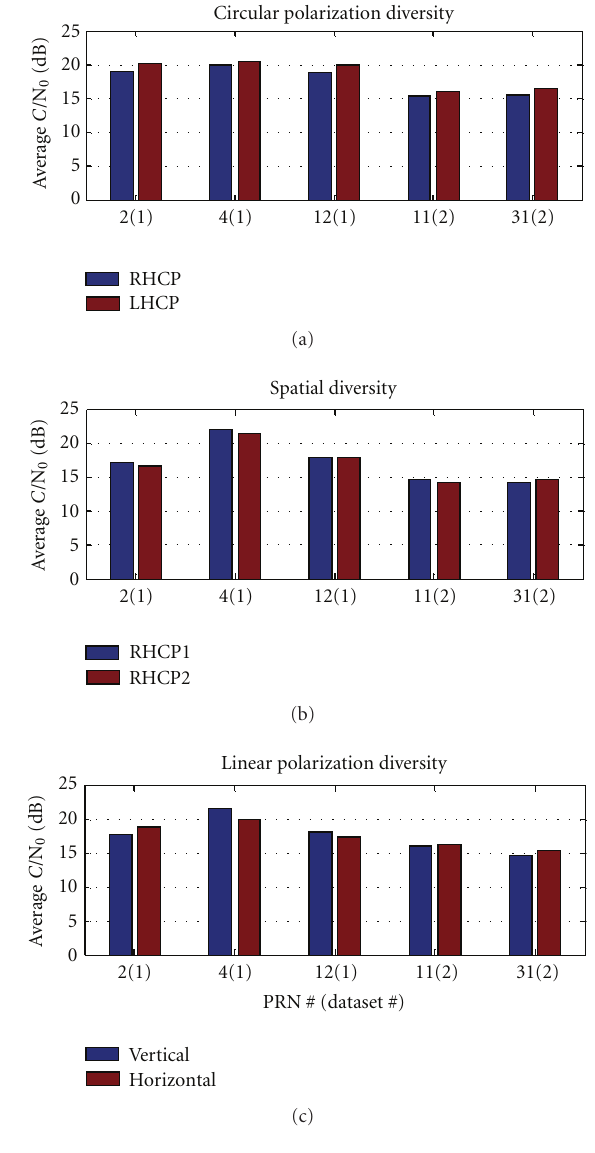
Figure 9: Average input SNR for di ff erent diversity